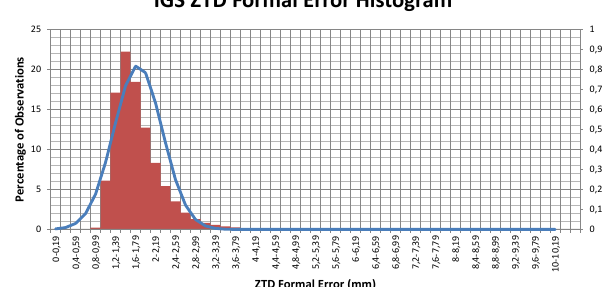
Figure 1. Histogram of the formal error of the IGS troposphere product (over the complete IGS network and the complete 15 + year history). The blue line is a Gaussian fit to the